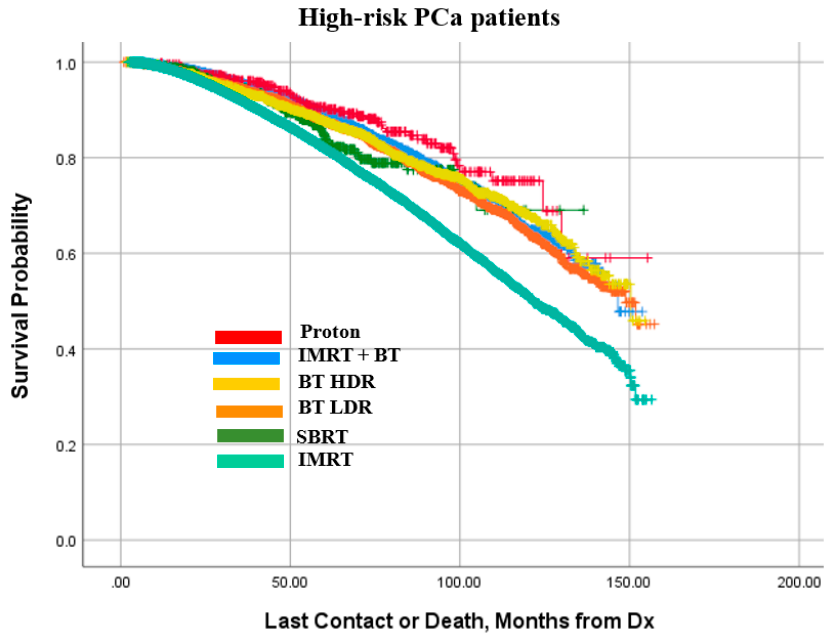
Figure 7. Kaplan–Meier curve for cumulative survival of high-risk patient prostate cancer (PCa) patients treated with the compared modalities.